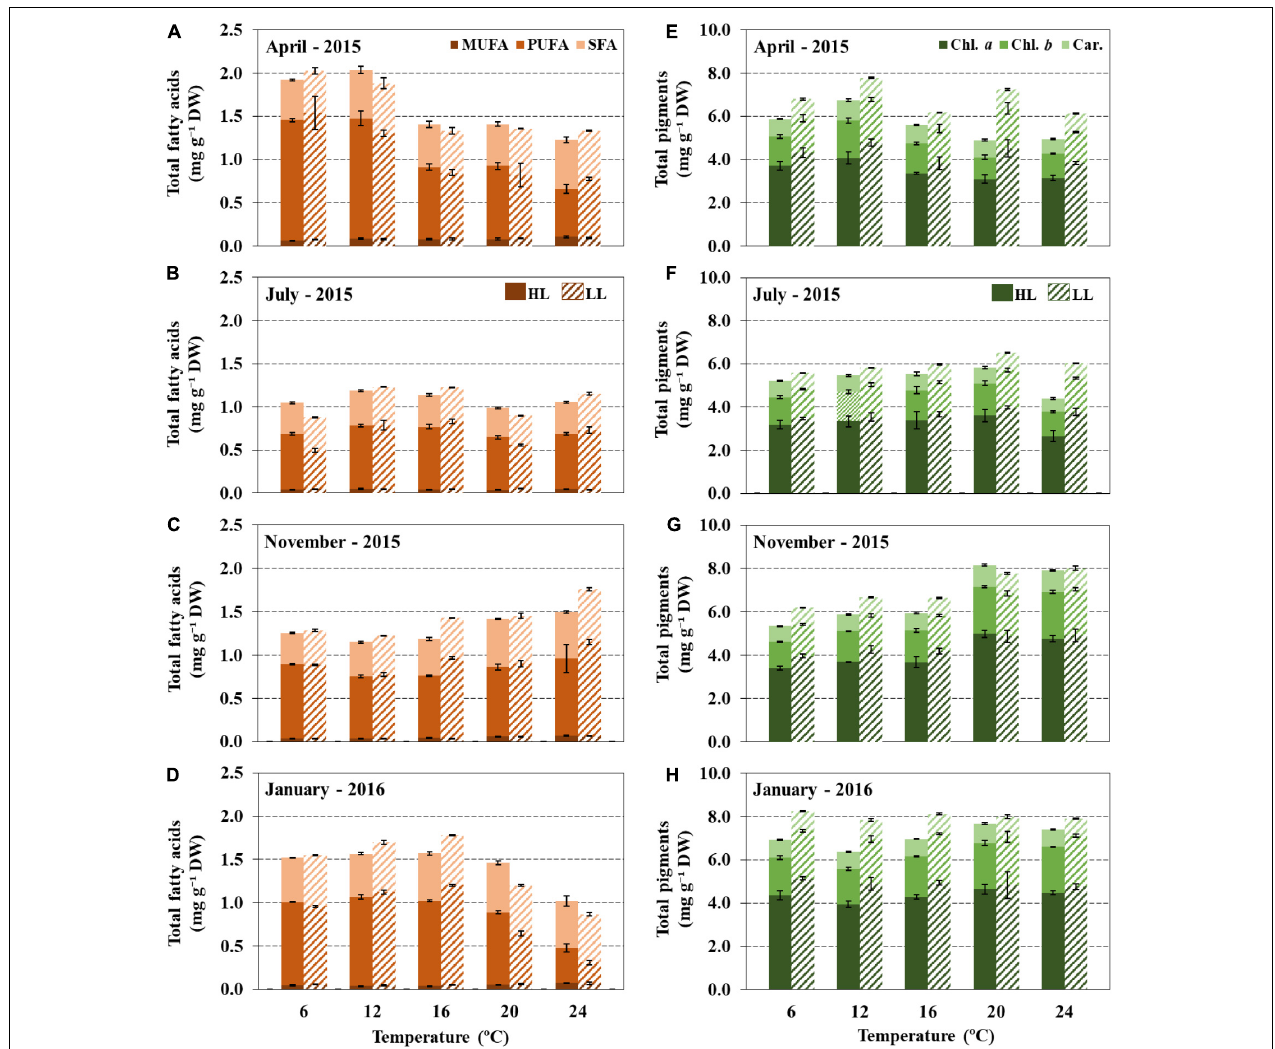
FIGURE 4 | Total fatty acid content (% DW) and composition (% of TFA) (A–D) , and pigment composition (E–H) of leaves of Irish Zostera marina exposed to an experimental temperature gradient (6, 12, 16, 20, and 24 ◦ C) and under high light (HL, 180 µ mol photons m − 2 s − 1 ), or low light (LL, 60 µ mol photons m − 2 s − 1 ) in April, July, November 2015 and January 2016. Results are expressed as mean ± SD ( n =